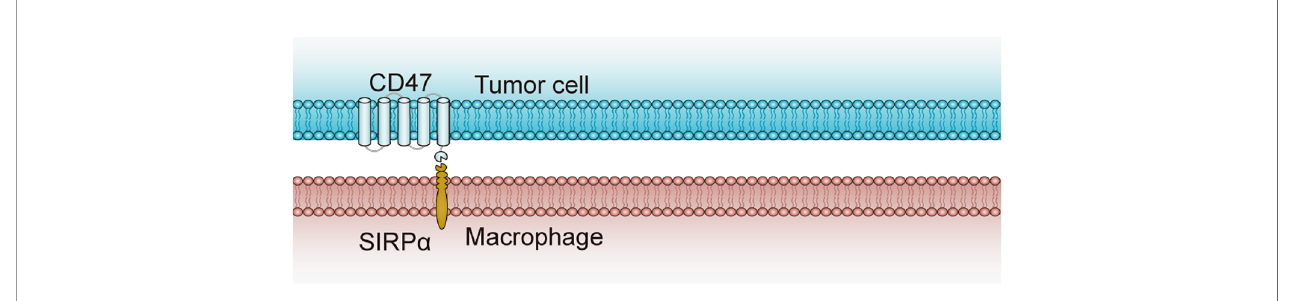
FIGURE 3 | Structure and interaction of CD47 and SIRP a . CD47 contains one N-terminal extracellular IgV-like domain and fi ve-membrane-spanning segments at the membrane. SIRP a , as the CD47 ligand, contains three extracellular IgSF domains, one transmembrane spanning region and an intracellular domain with ITIM motifs. CD47-SIRP a binding prevents the host cell from being targeted for phagocytosis, while anti-CD47 antibodies can block the suppression signal and promote phagocytosis by macrophages (27). CD47, cluster of differentiation 47; ITIM, immunoreceptor tyrosine-based inhibitory motif; SIRP a , signal-regulatory protein